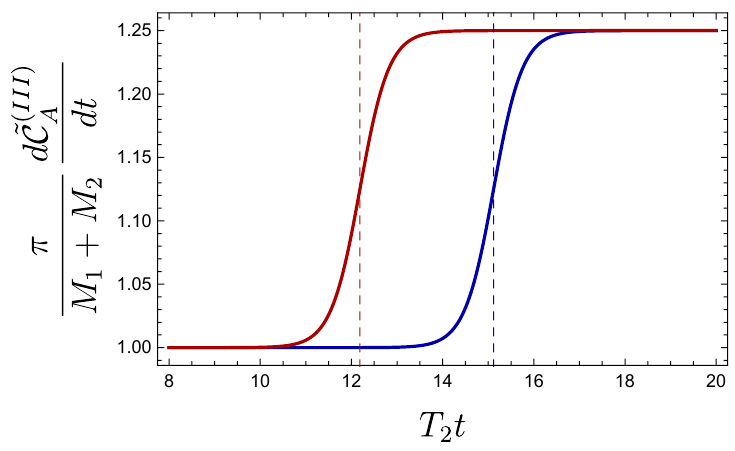
Figure 10. Rate of change of complexity for BTZ ( d = 2) black hole without the addition of the counterterm, given by eq. (3.93). We study the transition between late time rates for very light shock waves, with w = 1 + 10 (cid:0) 33 (red) and w = 1 + 10 (cid:0) 37 (blue). The vertical lines represent the characteristic transition times ^ t (cid:3) , given by eq. (3.96). For light but non-zero shock waves, the late time limit is similar to the eternal black hole for t < ^ t (cid:3) , but for t > ^ t (cid:3) , it becomes the rate in eq. (3.101) (with M 1 M 2 (cid:25)